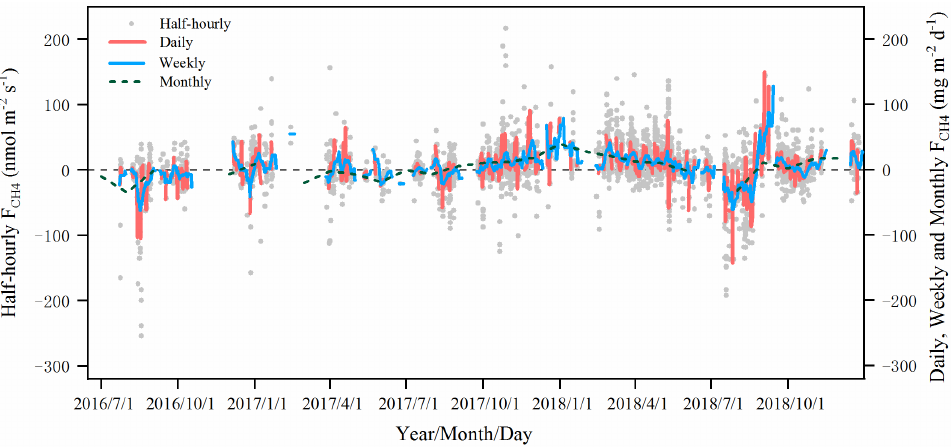
Figure 4. Time series of half-hourly (gray circles), daily (red lines), weekly (blue lines) and monthly (dotted line) CH 4 fluxes from 2016 to 2018.